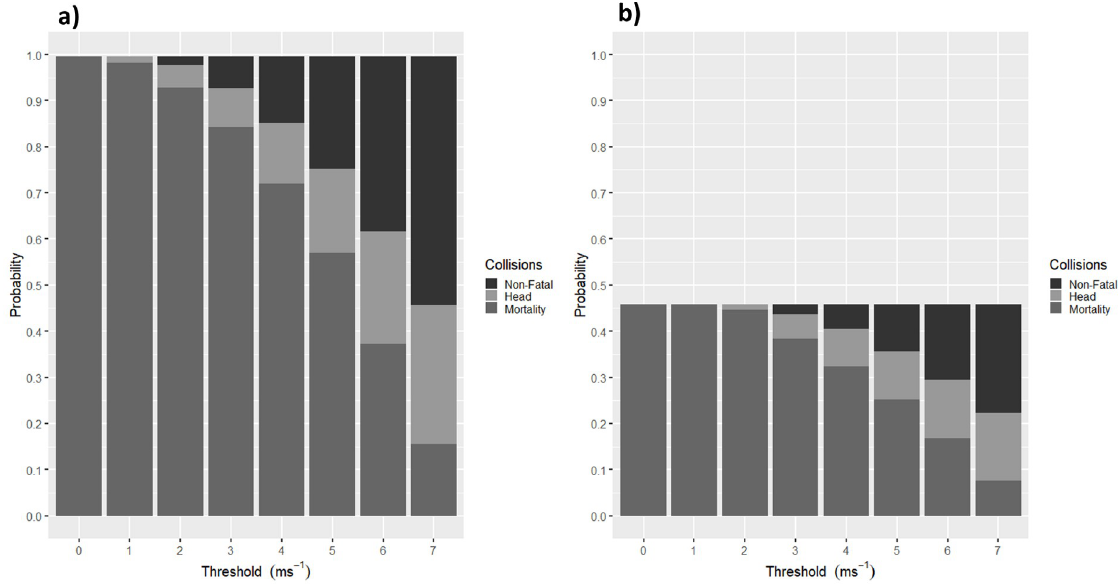
Fig 4. The probabilities for scenario a) A1R1 and b) A2R1 with a variety of collision speed thresholds applied from 0 to 7 ms -1 . The dark grey represents the mortality probability, which is classified as a collision that occurs at a greater speed than the threshold set, and the black represents the probability of an animal colliding at a speed lower than the threshold set and, therefore, is deemed to survive the collision. The light grey represents the probability that is made up of collisions above the threshold but where the collision was to the head of the animal.